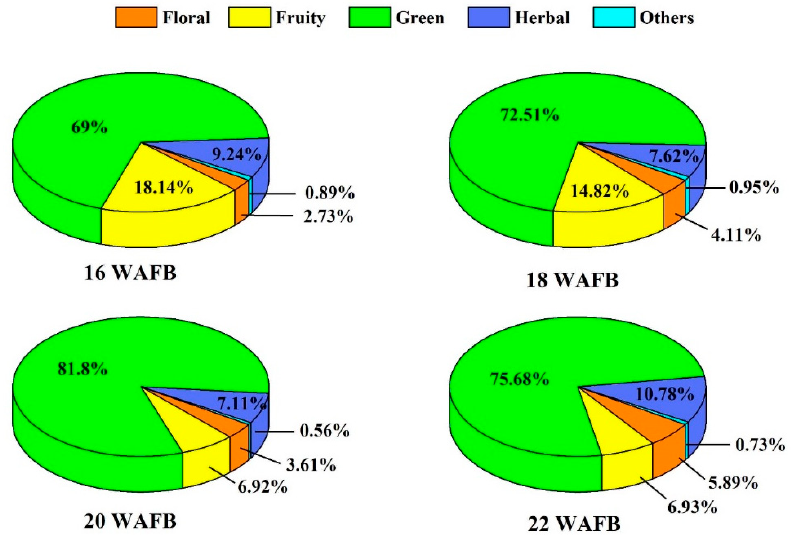
Figure 2. Pie charts representing the percentages of free volatile aroma compounds classified into odor types in Shine Muscat grapes harvested at 16, 18, 20, and 22 weeks after full bloom (WAFB): Others include citrus, earthy, fatty, minty, tropical, waxy, and aldehydic odors. The OAV of ( E )-2-hexen-1-ol, the only active compound representing the fruity scent, tended to decrease with ripening, while 1-hexanol with an herbal scent was highest in berries harvested at 22 WAFB. The OAVs of aldehyde compounds, including ( Z )-3-hexenal, ( E )-2-hexenal, and hexanal, responsible for green and herbaceous scents, were